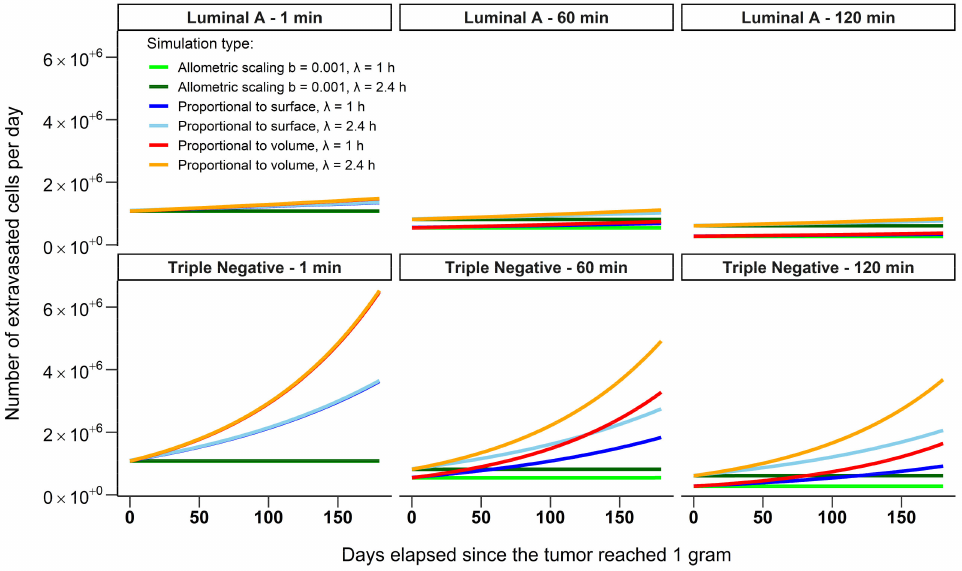
Figure 5. The number of extravasated cells per day for two different breast cancer types: triple- negative cancer which is fast growing and luminal A which is slow-growing. CTCs with half-lives of 1 and 2.4 h and a time for those cells to reach the target organ of 1, 60 or 120 min were considered in the simulation. The solid lines represent the median number of extravasated cells per day for a given simulation. Luminal A tumors grew by 0.175% per day while triple-negative cancer tumors grew by 1.003% per day. Note that the two lines for the simulations scaling to a small fraction of the tumor mass M (here M b with b = 0.001) (in green and dark green) are overlapping closely on the plots. The values for M, Pe and the number of shed cells are the same as in Figure